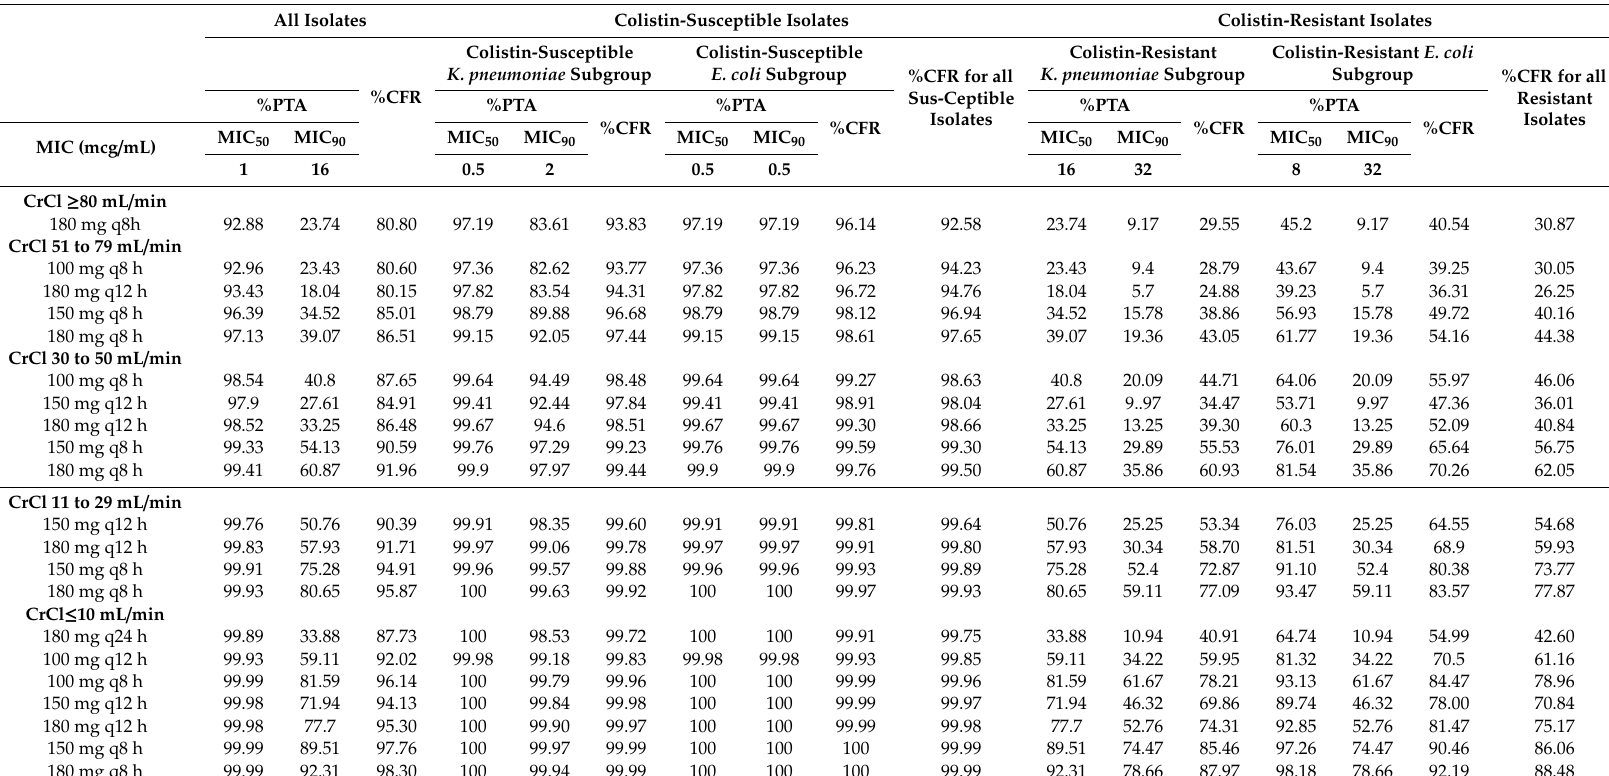
Table 8. %PTA and %CFR of our study regimens for All isolates, Colistin-susceptible isolates subgroup and Colistin-resistant isolates